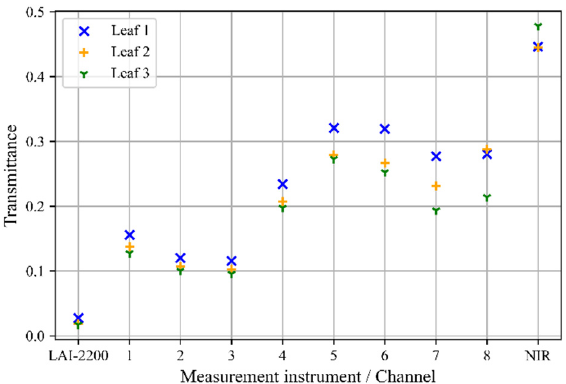
Figure 10. Comparison of the relative transmittance of multiple leaves of the Norway maple tree. The measurements were executed with the LAI-2200C and our sensor node channels 1 to 8 and NIR